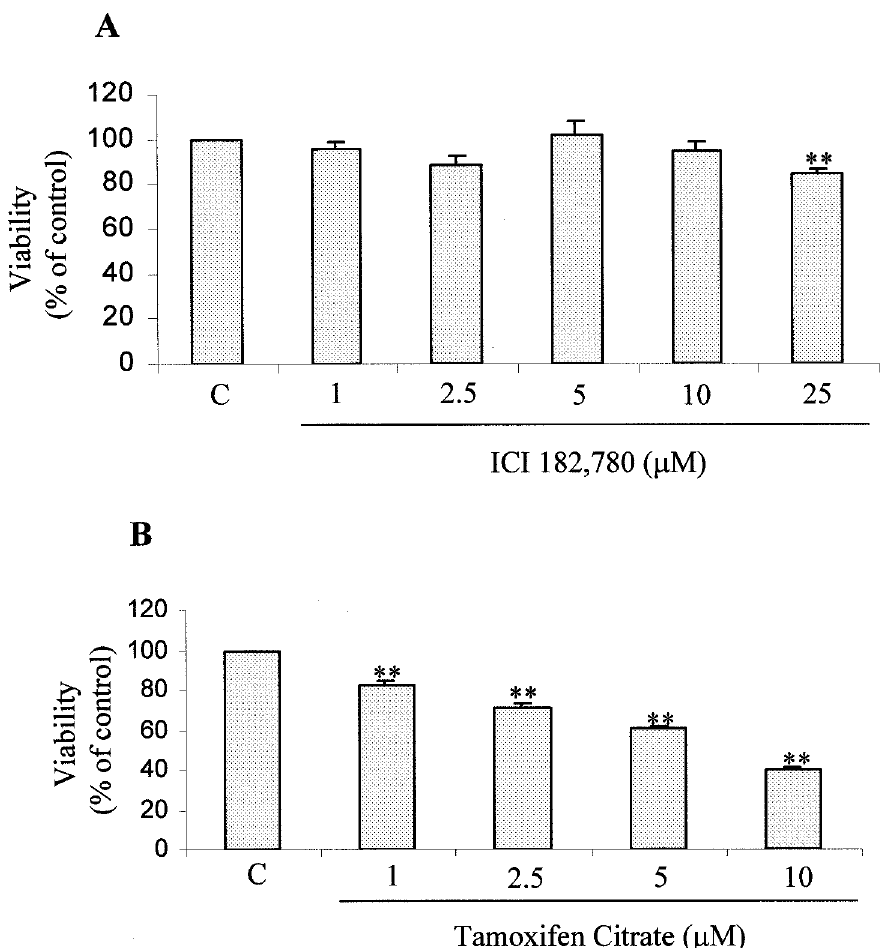
FIG. 1. Cell viability of CCRF-CEM cells when incubated in the presence of estrogen antagonists. Cells were incubated in the absence (control, C) or in the presence of ICI 182,780 (1–25 m M) (A), or with tamoxifen citrate (1–10 m M) (B). Cell viability was assessed by the MTT reduction test. The data shown are an average of three independent experiments. Values are mean±SD, ** p < 0.01 as determined by one-way ANOVA with Dunnett’s post